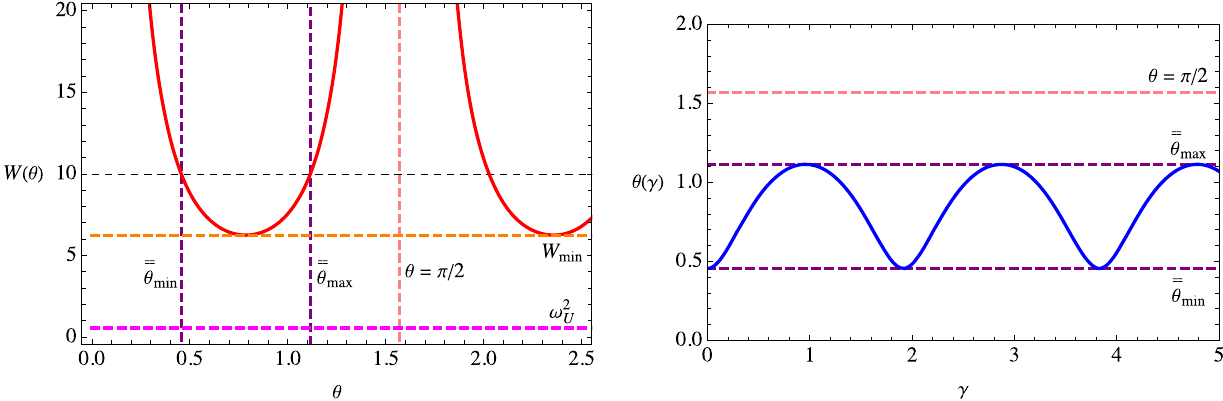
Fig. 11 The angular effective potential and the temporal evolution of the coordinate θ for the case of ˜ η < 0, plotted for Q = 9 M 2 and f θ = 10 M 2 . √ To plot θ(γ) , we have considered ω 0 = 10